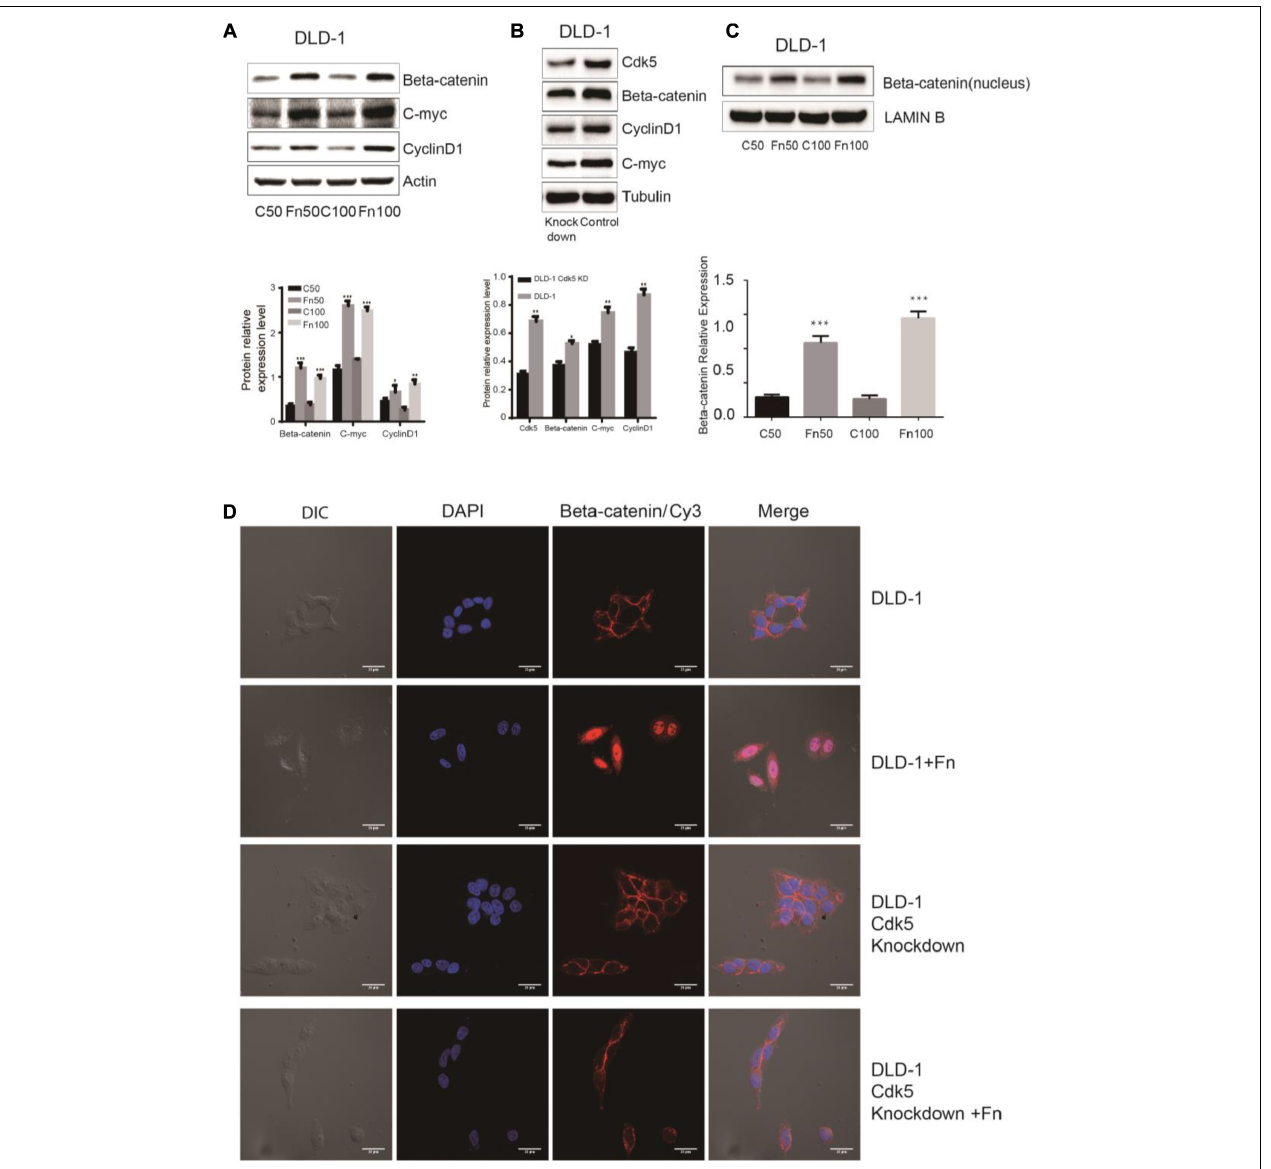
FIGURE 4 | Fusobacterium nucleatum activates Wnt/ β -catenin signaling and promotes the nuclear translocation of β -catenin through cyclin-dependent kinase 5 (Cdk5) in DLD-1 cell lines. (A) The expression levels and quantification of β catenin, c-Myc, and cyclin D1 treated with F. nucleatum were measured by Western blot (WB) analysis in DLD-1 cells. Data are expressed as mean ± SEM from at least three independent experiments. * P < 0.05, ** P < 0.01, and *** P < 0.001 vs. control. (B) The expression levels and quantification of Cdk5, β catenin, c-Myc, and cyclin D1 were measured by WB analysis in DLD-1 and Cdk5-knockdown DLD-1 cells. Data are expressed as mean ± SEM from at least three independent experiments. * P < 0.05 and ** P < 0.01 vs. control. (C) The expression levels and quantification of nuclear beta-catenin treated with F. nucleatum were measured by WB analysis in DLD-1 cells. Data are expressed as mean ± SEM from at least three independent experiments. *** P < 0.001 vs. control. (D) F. nucleatum affects β catenin cellular localization through Cdk5. Cells were seeded onto coverslips and treated with F. nucleatum or control for 12 h. The cells were then subjected to immunofluorescence staining. The cells were immunostained with an anti- β catenin (red fluorescence). The nucleus was stained with 4 (cid:48) ,6-diamidino-2-phenylindole (DAPI) (blue fluorescence). Cy, cyanine; DIC, differential interference